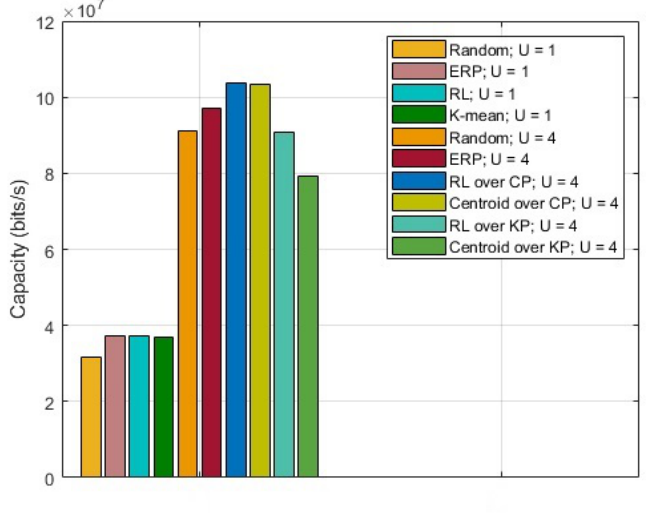
Figure 2. Capacity for